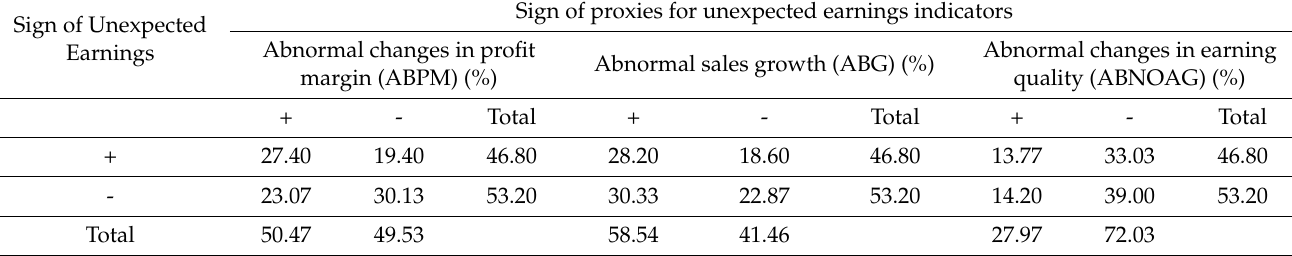
Panel B: Contingent table of the signs of the unexpected earnings vs. unexpected earnings predictors, a shown as the percentage out of the total sample observations.